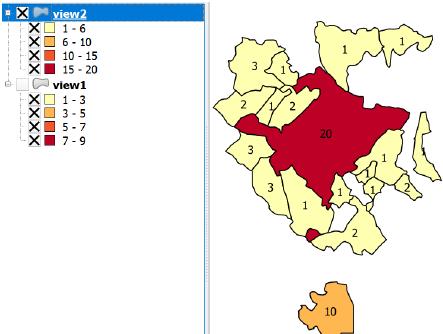
Figure 18. The ranking of the municipalities according to the number of retrieved GeoReports (in the first two